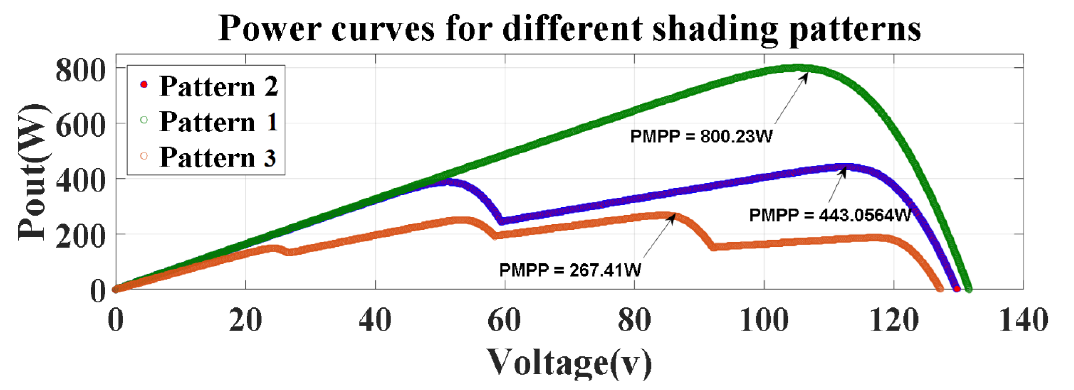
Figure 10. Power curves under different shading patterns.